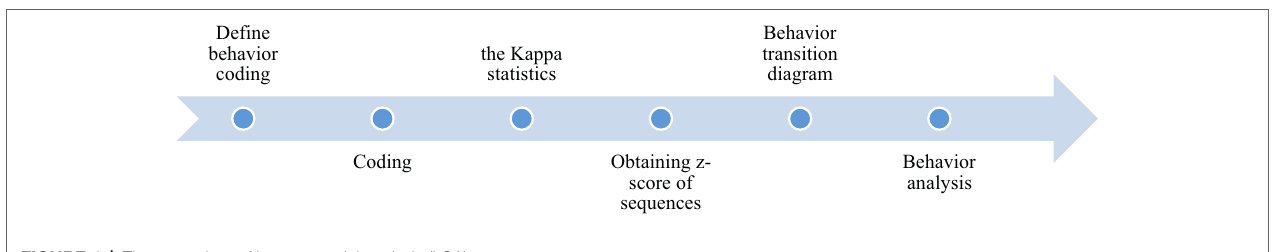
FIGURE 4 | The procedure of lag sequential analysis